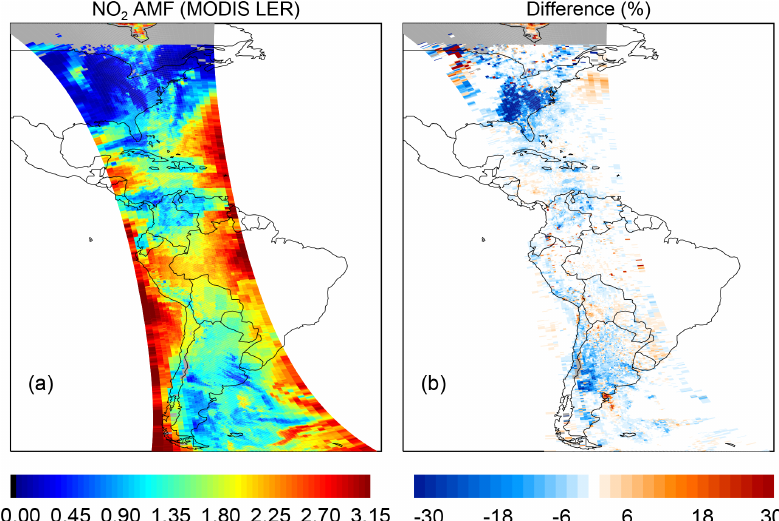
Figure 14. (a) OMI tropospheric NO 2 air mass factor (AMF) calculated using geometry-dependent MODIS-based LER; (b) percent differ- ences with respect to climatological LERs for OMI orbit 12414 on 14 November 2006.